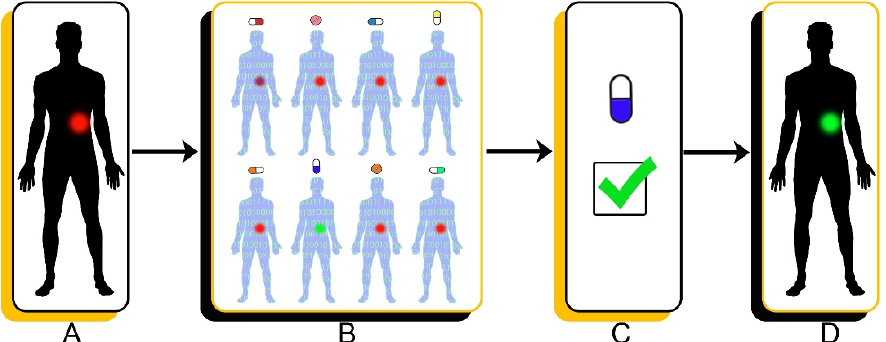
Figure 4. DT concept for personalized medicine. ( A ) A patient with a local sign of disease (red). ( B ) Patient’s DT is created and virtually treated with different treatments/medicines in various combinations. ( C ) Treatment showing the best results is chosen. ( D ) Personalized medicine is given to the patient to treat them (green). (Adapted from [83]).